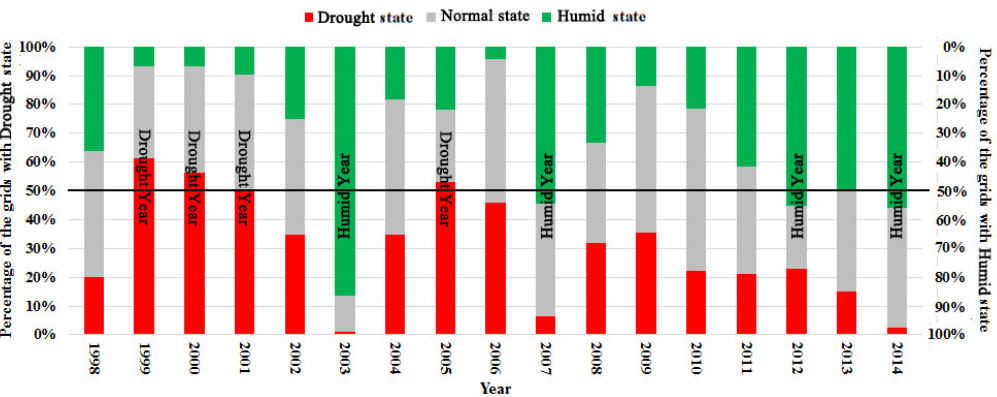
Figure 10. The temporal distribution of drought and humid events from 1998 to 2014. The green, red and gray columns respectively represent the percentage of drought-state grids, humid-state grids, and normal-state grids out of 1150 total grids.